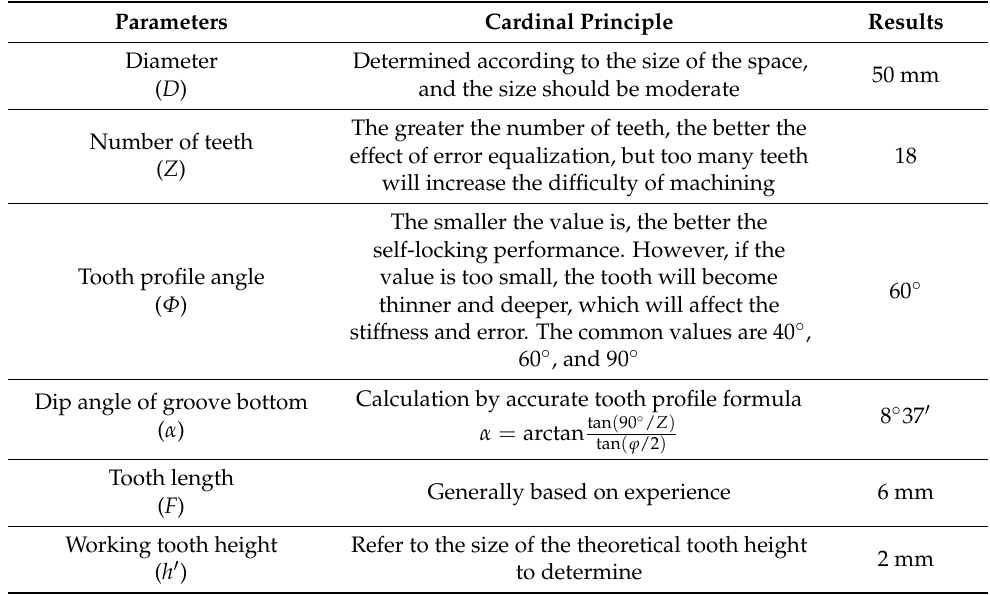
Table 1. The design results of the main parameters of the end-toothed